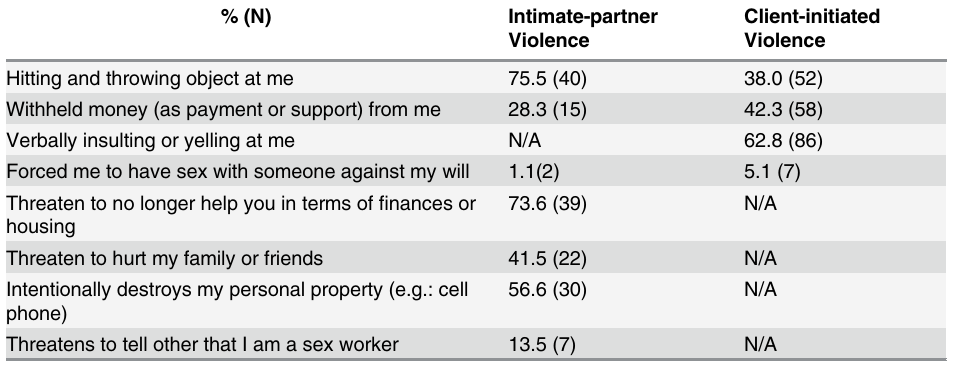
Table 2. Types of violence reported by female street-based sex workers who experienced intimate- partner violence or client-initiated violence in Shanghai, China from 2011-2012(N = 218).